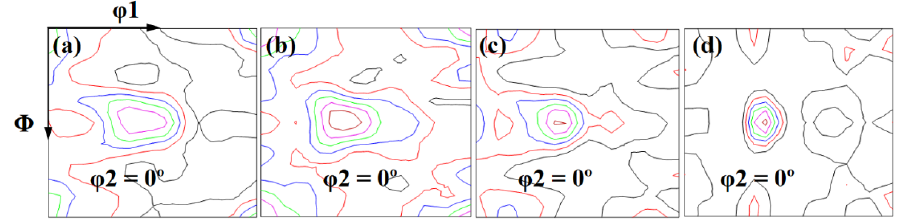
Figure 2. Sections (φ = 0°) of ODFs on the rolling plane of hot -rolled state 2524-T3 alloy after cold rolling: ( a ) 0%; ( b ) 10%; ( c ) 40%; ( d ) 80%.